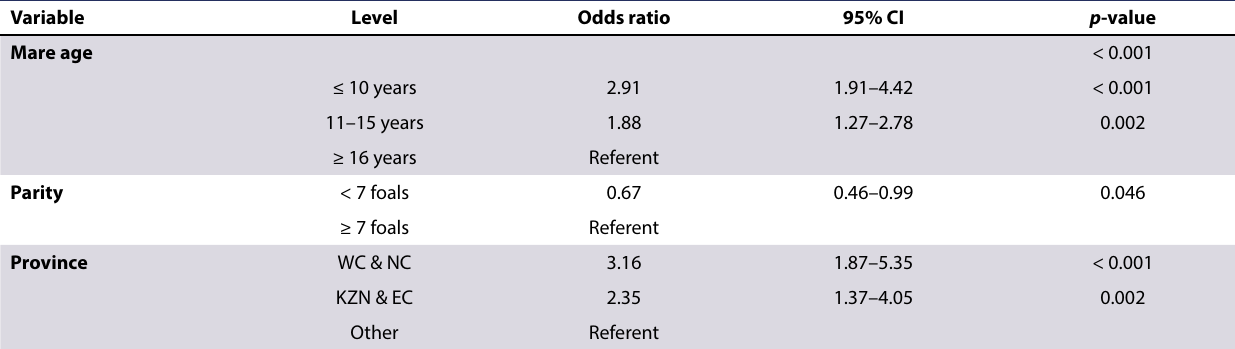
Table VI: Multivariable associations between potential covariates and the observation of a live foal identified during 2020 and 2021 for 1 984 Thoroughbred maiden and barren mares and 2 120 pre-breeding screenings for venereal pathogens in South Africa